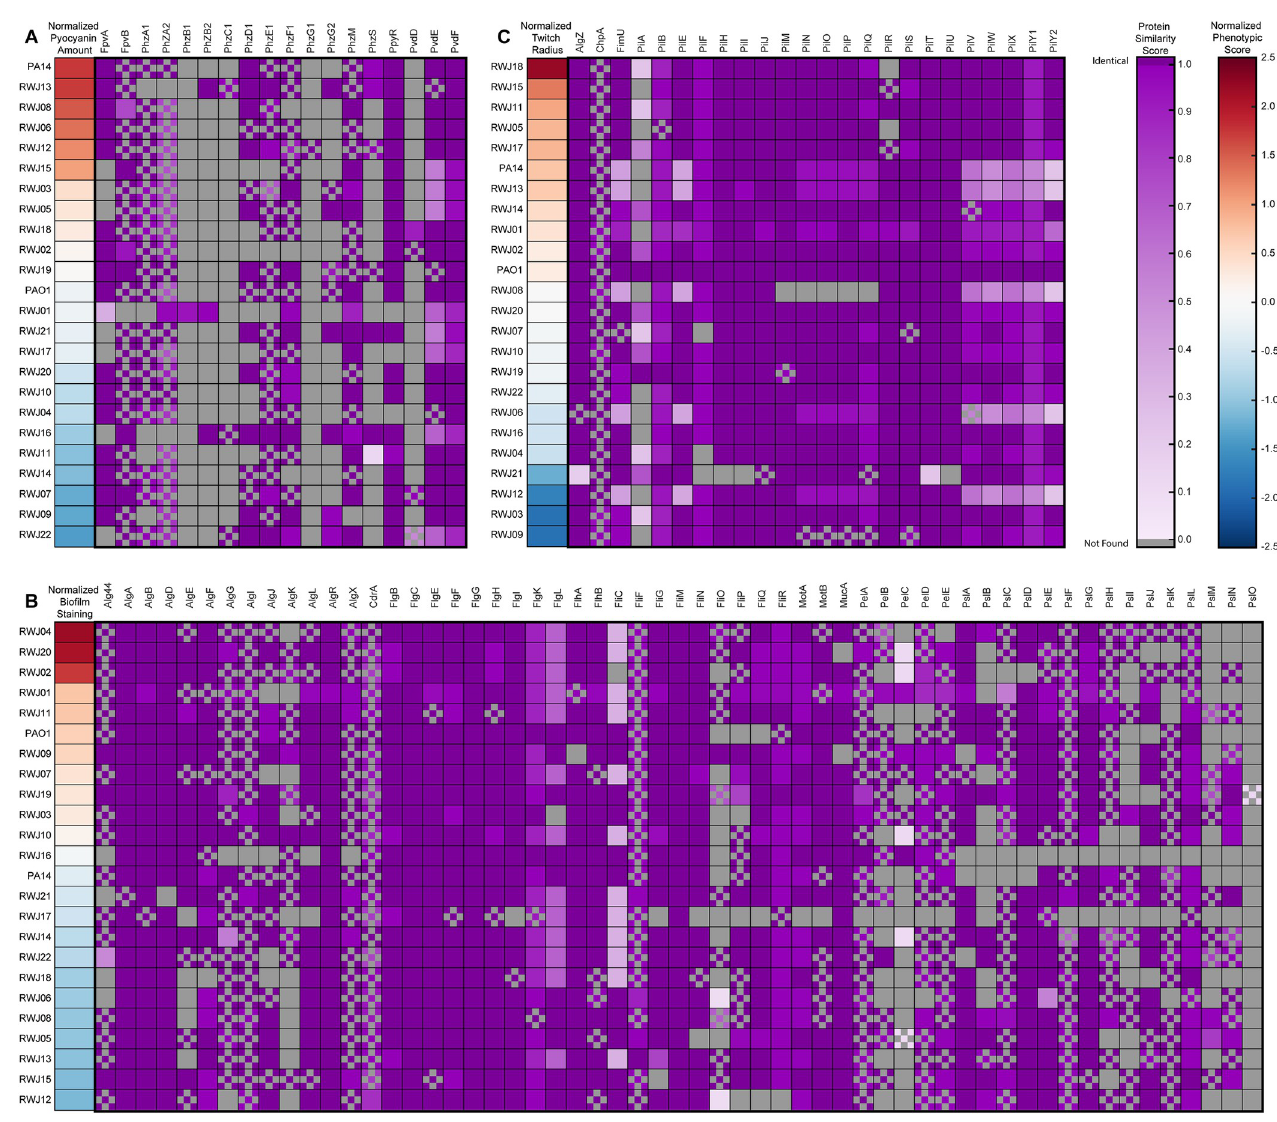
Fig 4. Protein similarity amongst strains shows high homology amongst most genes. Genes involved in the (A) pyocyanin and pyoverdine, (B) biofilm, (C) twitching were compared for similarity. (Left) Strains are ordered by their normalized phenotypic score from dark red indicating high to dark blue indicating low. (Right) Similarity scores between the gene in published PAO1 reference genome and ORF from our assembly. Dark purple on indicates 100 percent similarity with decreasing saturation indicating decreasing similarity. Gray boxes indicate that the gene was not found in the scaffolds of the strain and could indicate a loss of the gene or be the result of incomplete assembly of contigs. Checkerboard pattern indicates that the ORF was found running up to the edge of a contig and was scored based on the portion of the protein present. PA14 and PAO1 comparisons shown are based on our de novo assembly of these strains to provide a baseline for our sequencing and assembly pipeline. For scores calculated based on full length template see S1